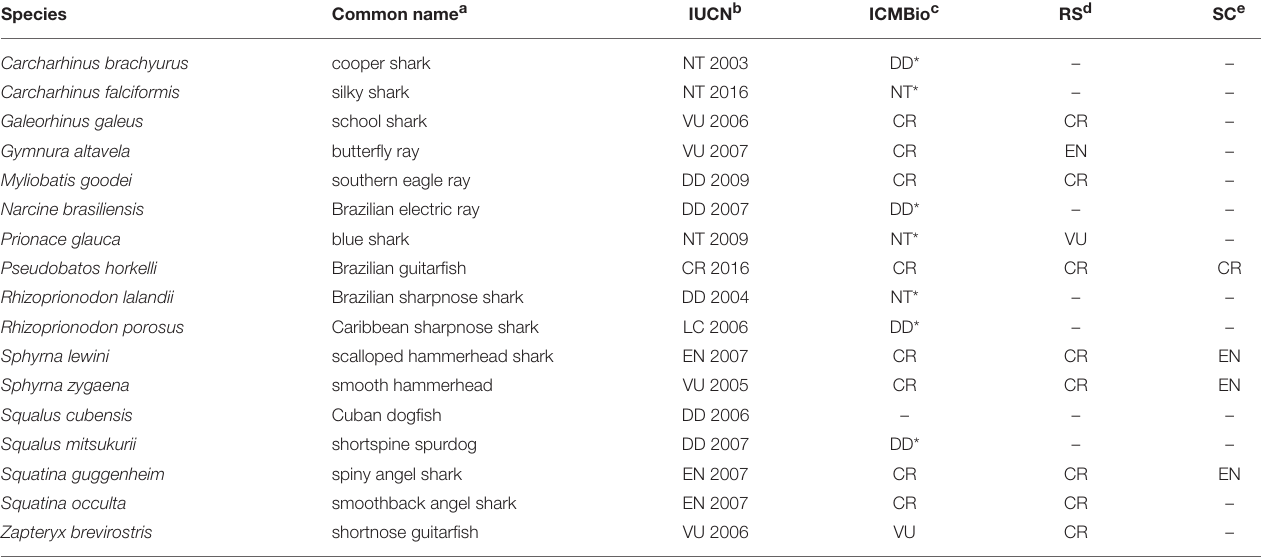
TABLE 2 | Conservation status (global, national, and regional) of the species found in this study.